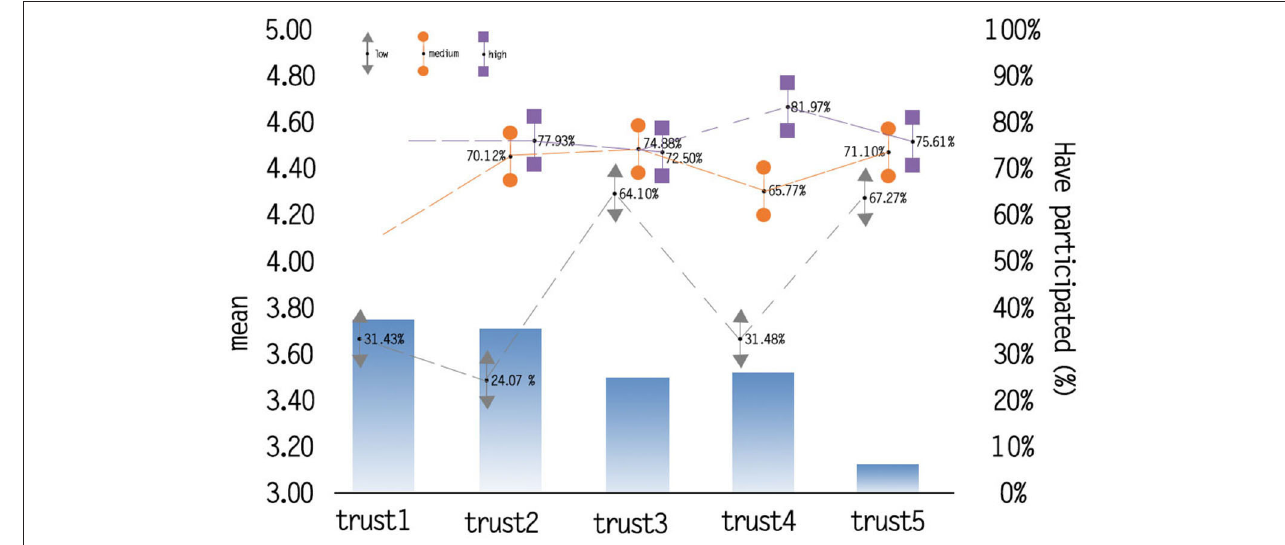
FIGURE 2 | Means and the participating percentages among the dimensions of